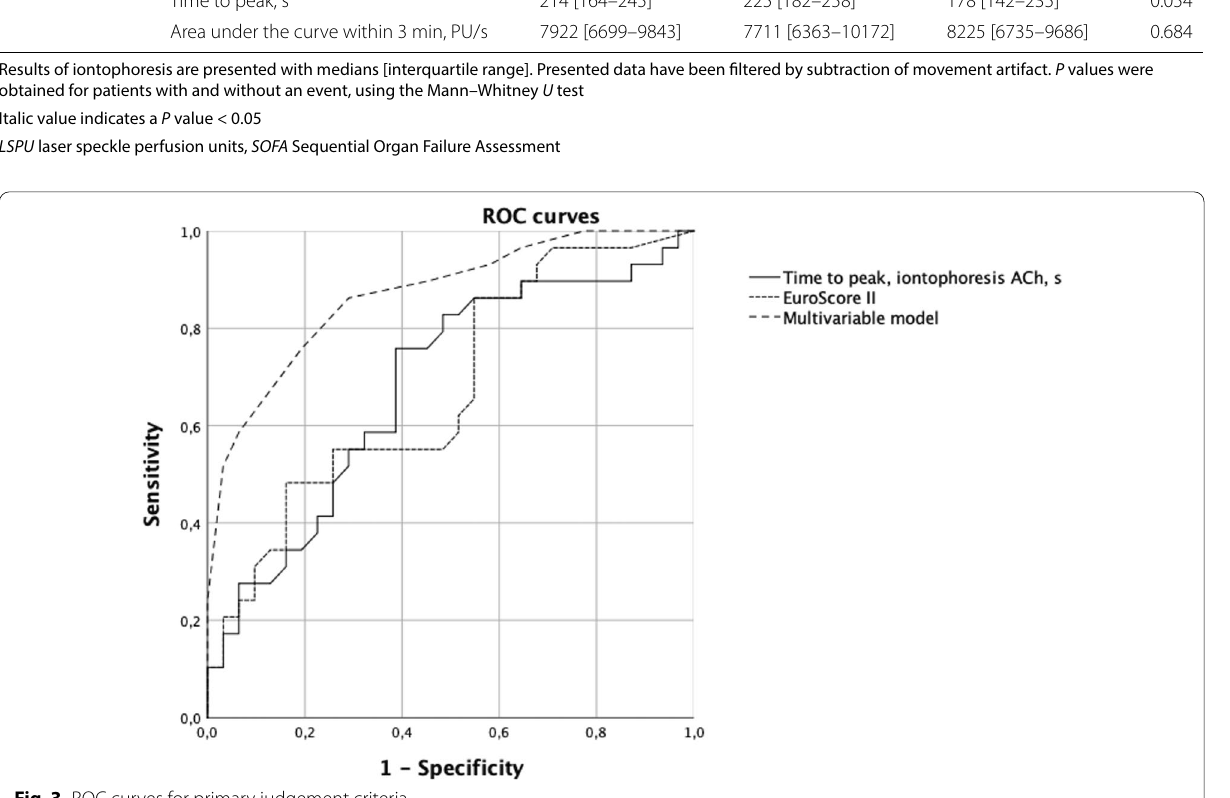
Fig. 3 ROC curves for primary judgement